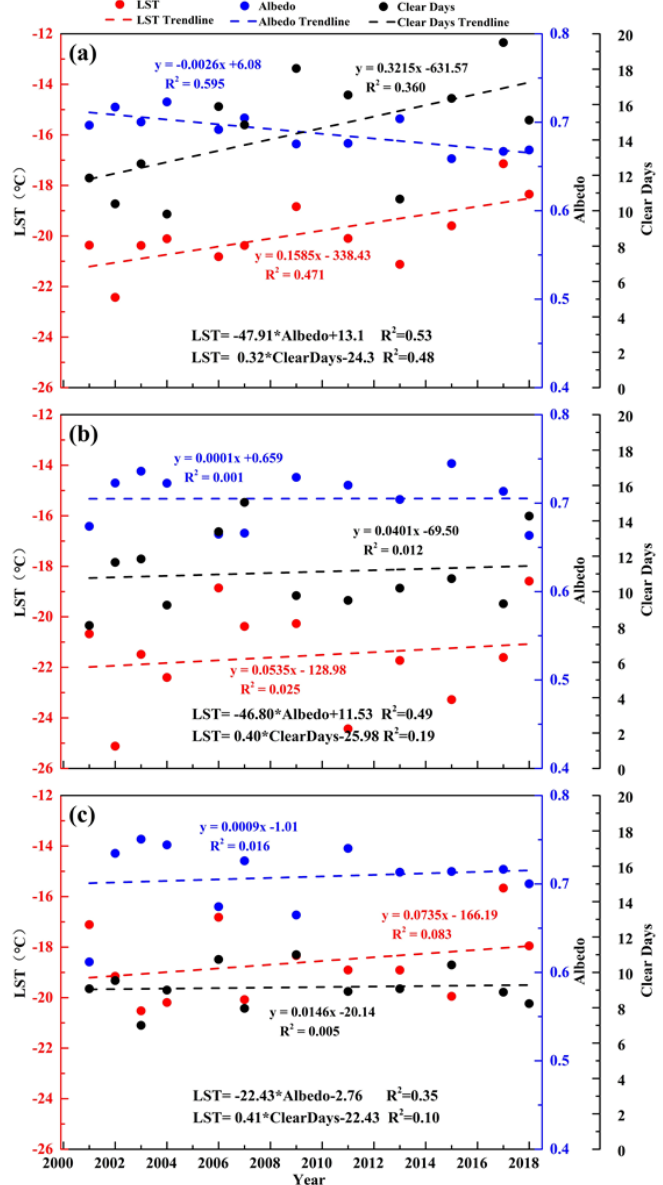
Figure 7. Comparison of LST (land surface temperature) (red), surface albedo (blue), and the number of clear days (black) in December, January, and February from 2001 to